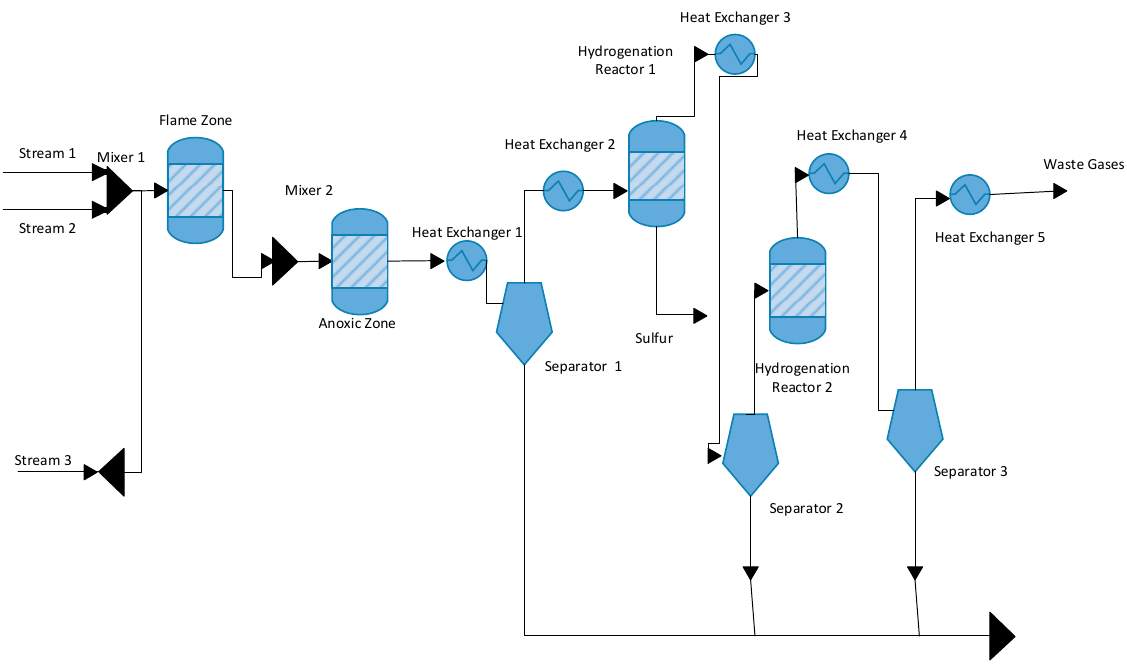
Figure 1. Block Flow diagram of the Claus process.